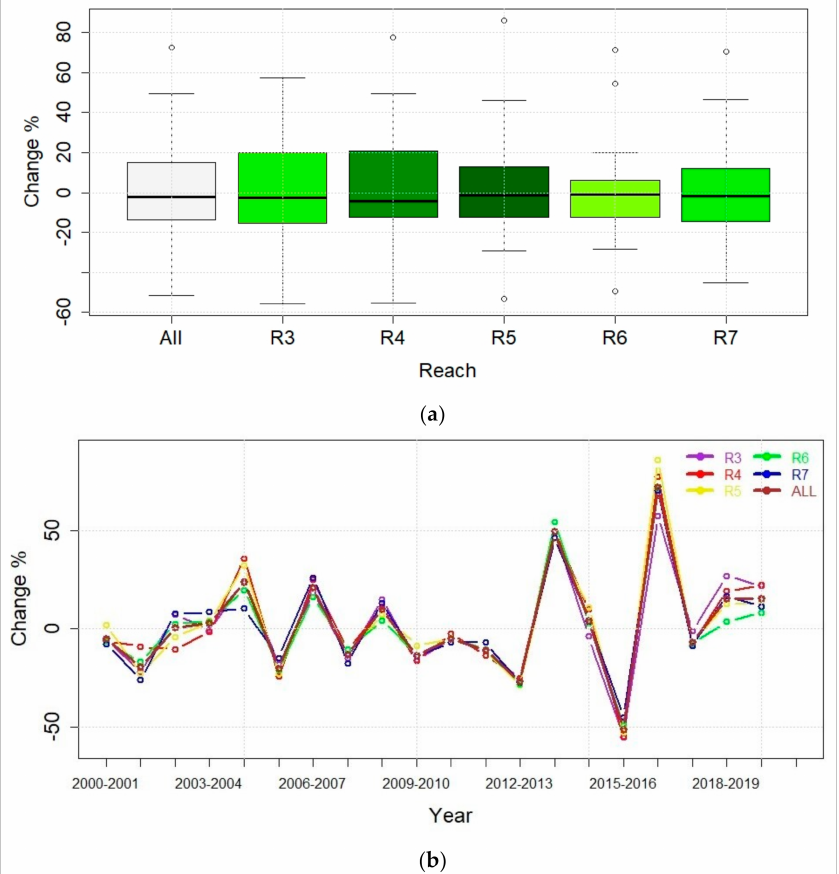
Figure 8. The percent change in daily water use for the peak growing season for five reaches and the entire riparian corridor (All) is shown using plots with a horizontal line, box, and whisker ends that indicate the median, 25th and 75th percentiles, and the 10th and 90th percentiles, respectively, and the data points outside this range are shown by dots ( a ). The rate of change in ET from year-to-year from 2000 to 2020 for each reach ( b